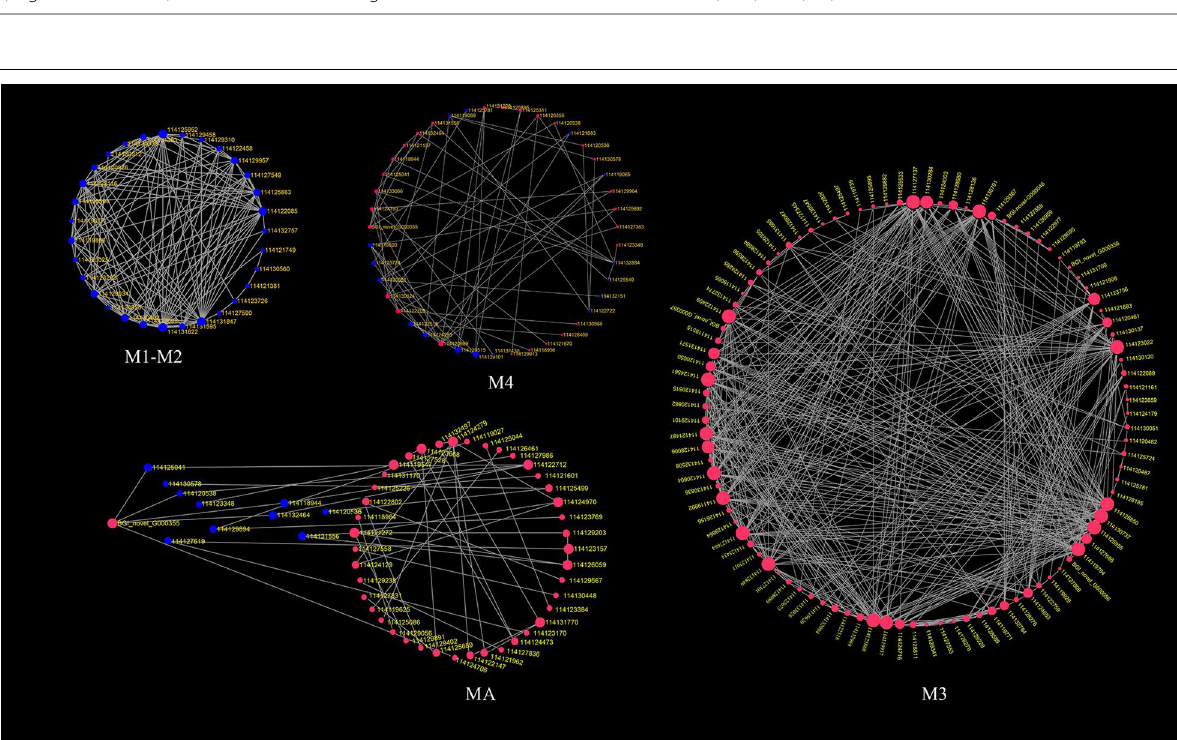
Fig. 10 Co-expression network of relevant modules and corresponding related phenotypes in specific developmental periods. Node size: larger indicates a more interactive, smaller indicates a less interactive. Node color: Red indicates up-regulated gene, Green indicates down-regulated